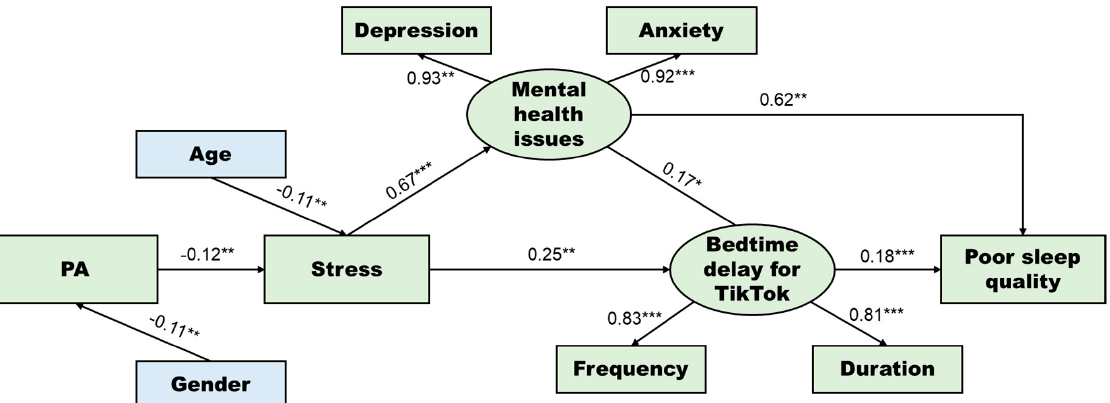
Figure 2. Final structural equation modeling (SEM) model describing the direct effects between variables. Note: * p < 0.05; ** p < 0.01; *** p < 0.001. As a higher Cronbach’s alpha for sleep quality (PSQI) score indicates worse sleep quality, the “sleep quality” in the framework was replaced with “poor sleep quality” in the final